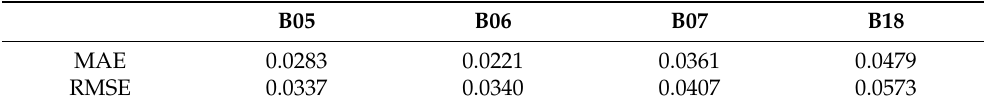
Table 4. Prediction results of four batteries.